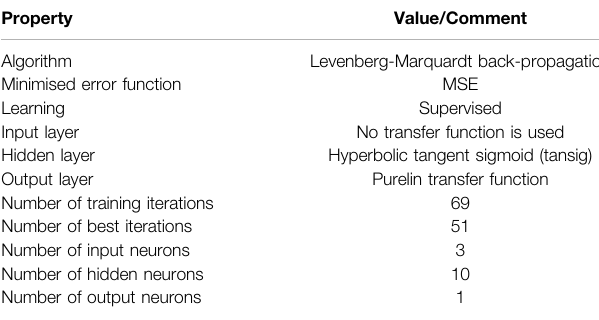
TABLE 2 | Network con fi gurations/features for the developed